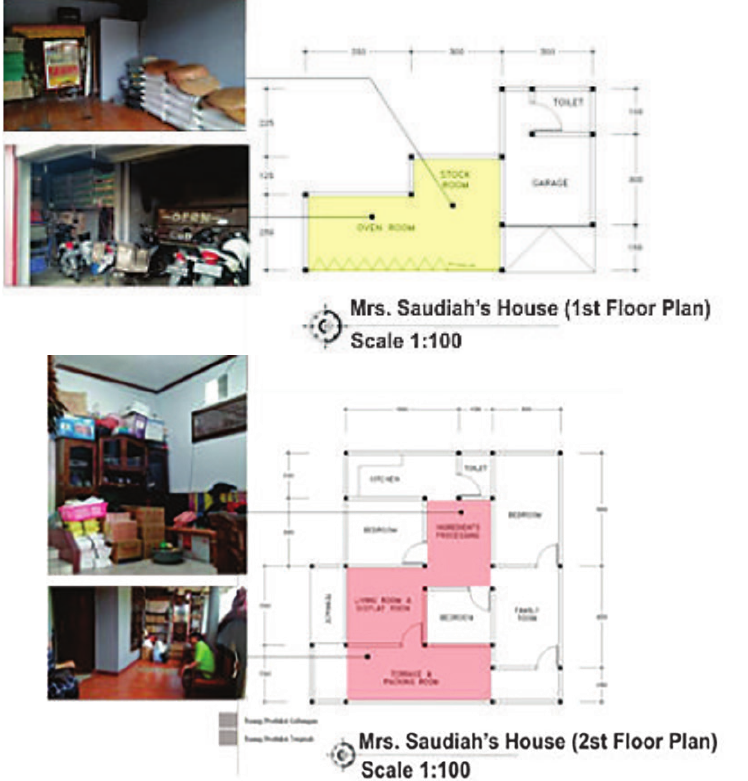
Figure 5. Production space and residential space separated in Mrs. Saudiah house (Case